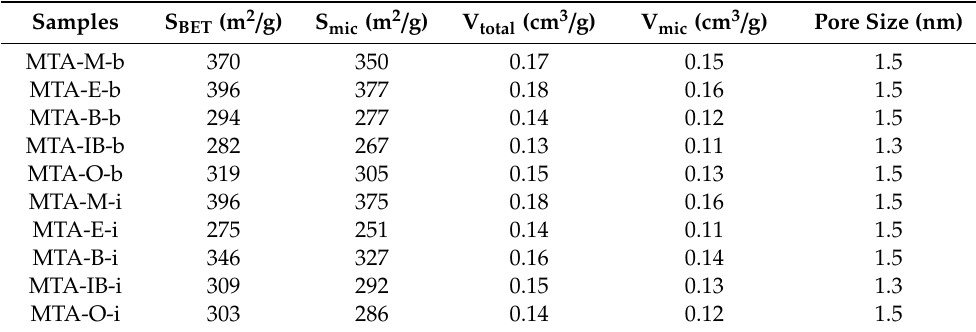
Figure 3. The corresponding pore size distribution curves of samples MTA-b ( A ) and MTA-i ( B ) calcined at 400 ◦ C. For clarity, the pore size distributions curves of MTA-E-b / MTA-E-i, MTA-B-b / MTA-B-i, MTA-IB-b / MTA-IB-i, MTA-O-b / MTA-O-i are o ff set along the Y -axis by 0.16, 0.32, 0.48, and 0.64 cm 3 / g, respectively. Table 1. Brunauer–Emmett–Teller (BET) surface areas and pore structures of various samples calcined at 400 ◦ C.